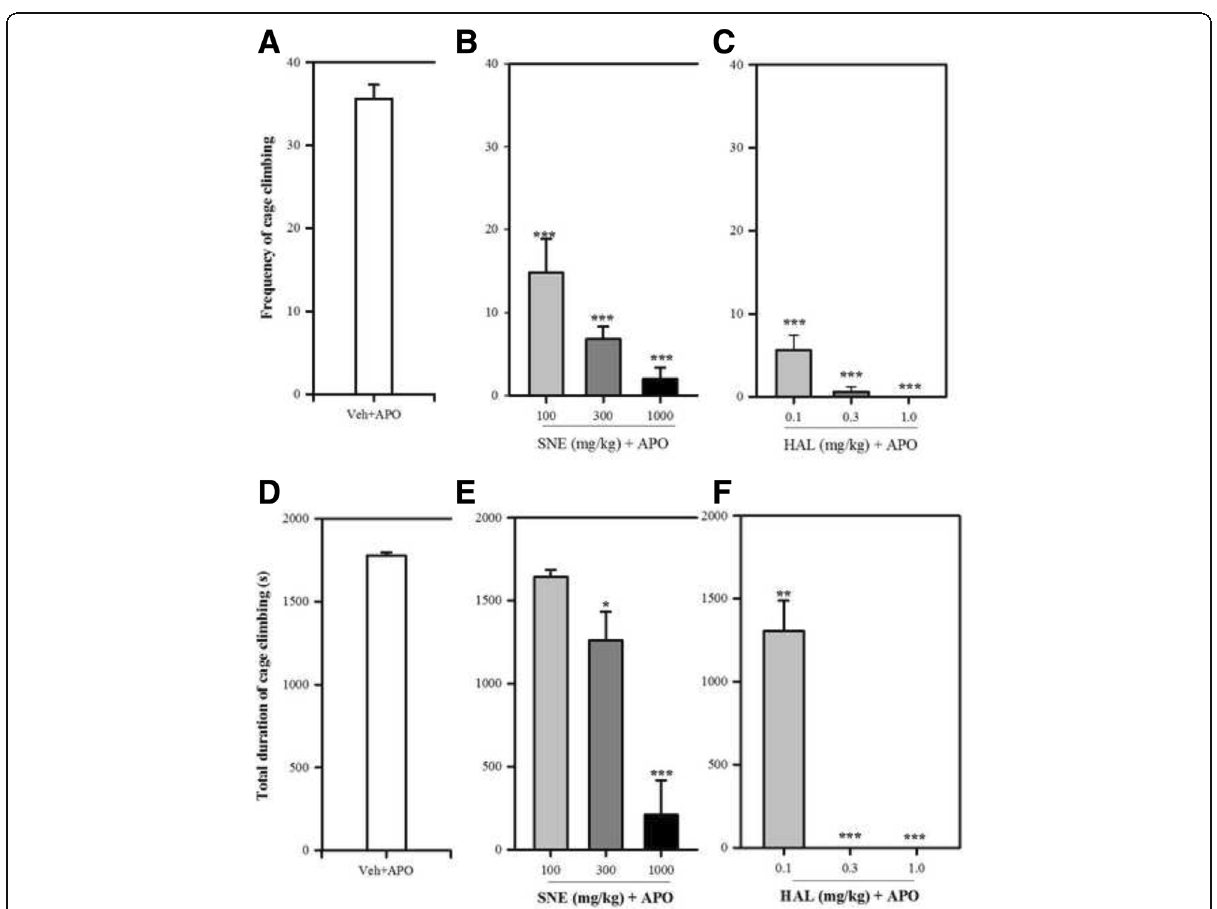
Fig. 8 Effect of SNE, HAL and vehicle (Veh) on the total frequency and duration of cage climbing of mice, 30 min post apomorphine (APO) (2 mg/kg, i.p) treatment. Data are mean ± SEM ( n = 5). * P ≤ 0.05, ** P ≤ 0.01, *** P ≤ 0.001 compared with Veh + APO group (one-way ANOVA followed by a Dunnett ’ s multiple comparison post hoc